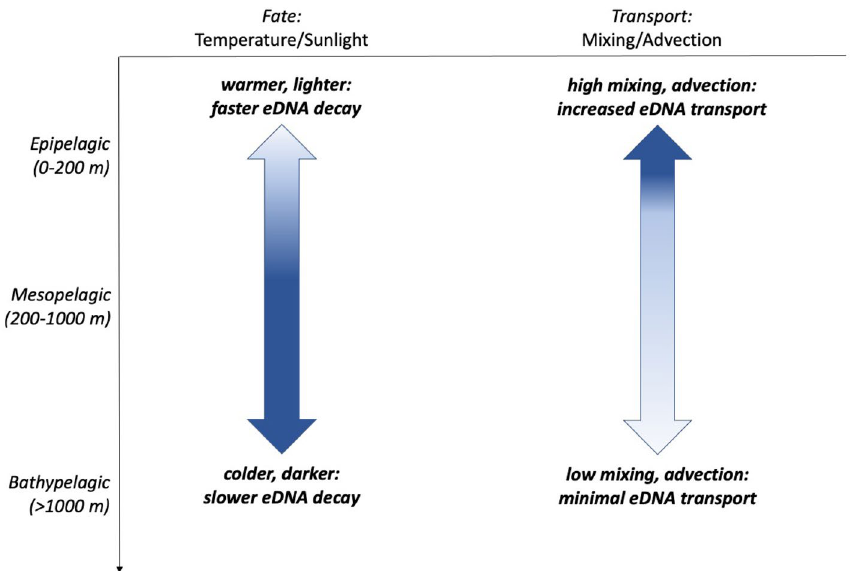
Figure 7. Variation of the influence of different processes at different depths of the water column. Y-axis shows depths from the mechanistic model. The left arrow shading indicates higher temperatures and more sunlight in surface waters transitioning to lower temperatures and no sunlight in deeper water. The right arrow shading indicates higher velocities and mixing in the water column in surface waters transitioning to low mixing and advection in deeper